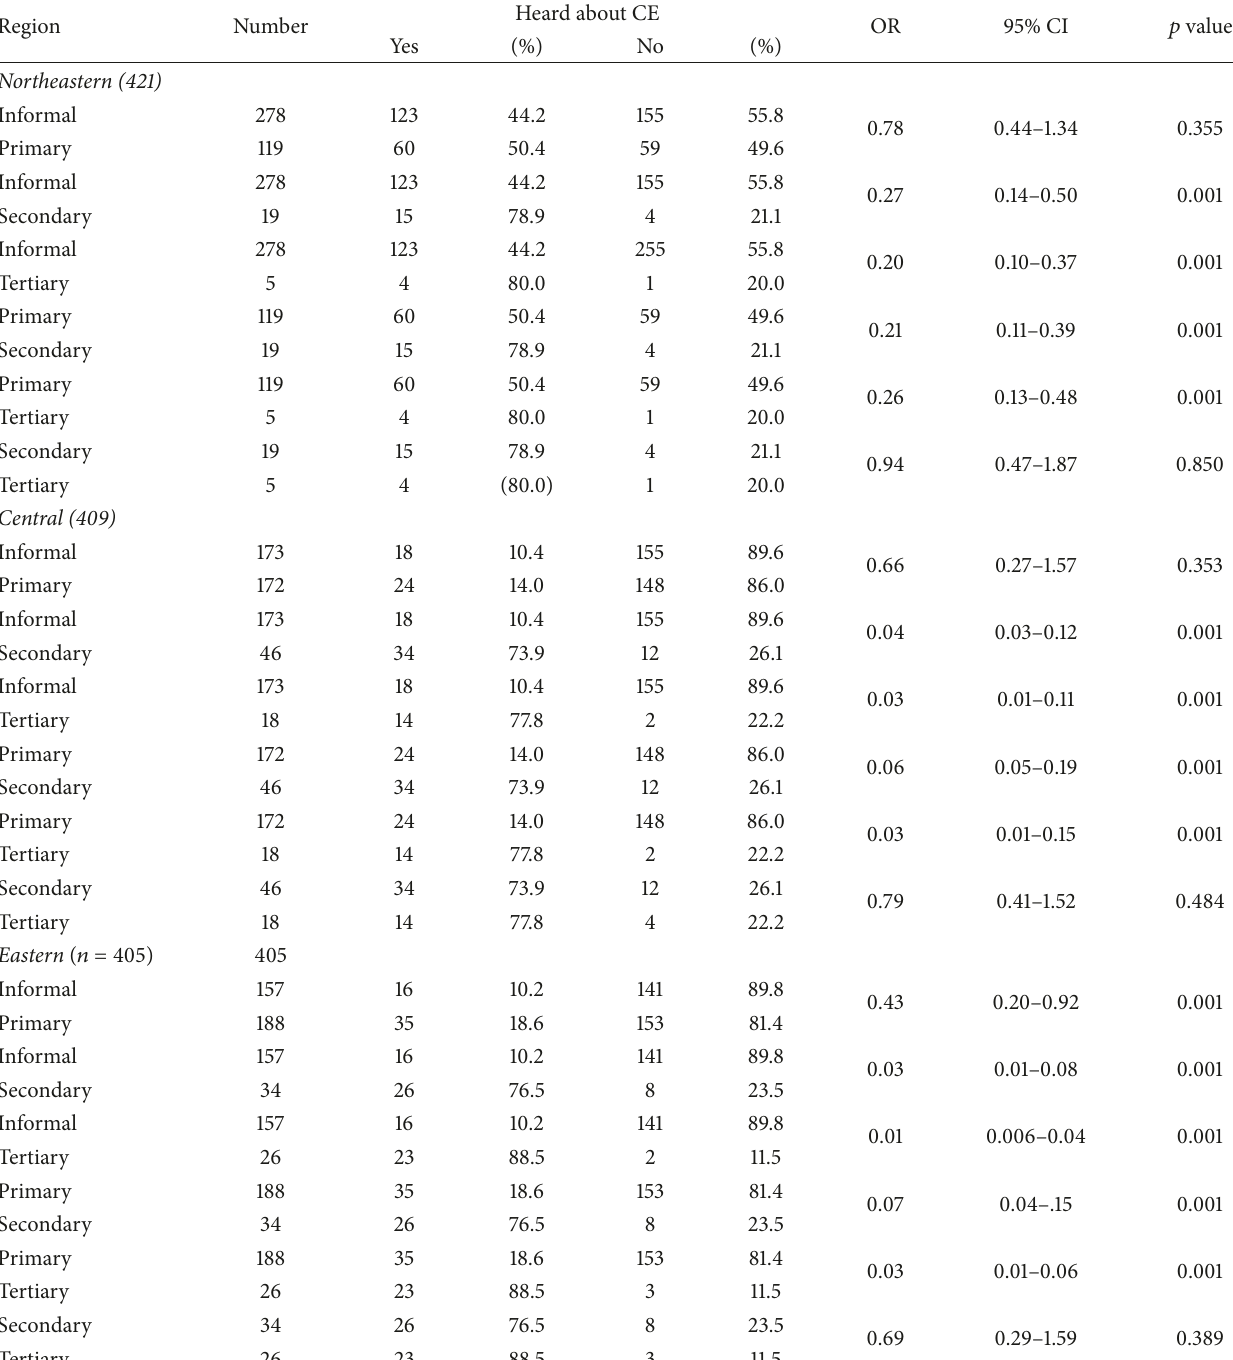
Table 3: Knowledge of communities about CE infection according to the level of